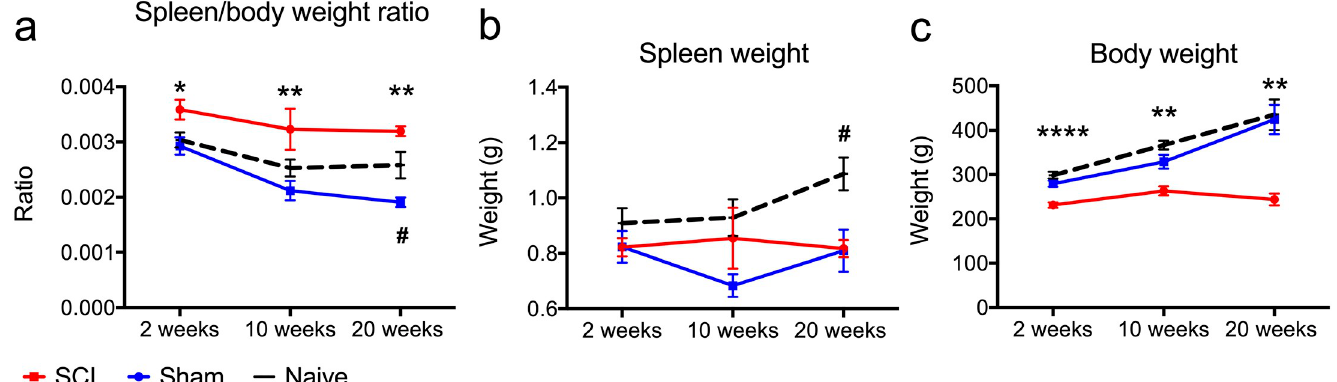
Fig 5. Larger spleen/body weight ratio following cervical SCI. (a) The spleen/body ratio was significantly higher in rats with cervical SCI compared to shams at all time points of the study. Also, when compared to the naive group, rats that received a sham injury had a smaller spleen/body weight ratio at 20 weeks. (b) Absolute spleen weight was not different between the cervical SCI and sham group. Also, the naive group had significantly larger spleen masses compared to the sham group at 20 weeks. (c) Rats with cervical SCI had significantly lower body weight compared to their sham counterparts at all time points of the study. There was no significant difference in body weight between sham and naive rats. One-way ANOVA with Bonferroni post hoc test was conducted to compare groups within each time point. � Indicates significant difference between sham and cervical SCI groups, whereas # indicates significant difference between sham and naive groups. � / # p < 0.05, �� p < 0.01, ��� p < 0.001, ���� p < 0.0001 ( p indicates values for post-hoc tests), N = 6–12 (2 weeks); 6–8 (10 weeks); 4–6 (20 weeks) rats/group, mean ±